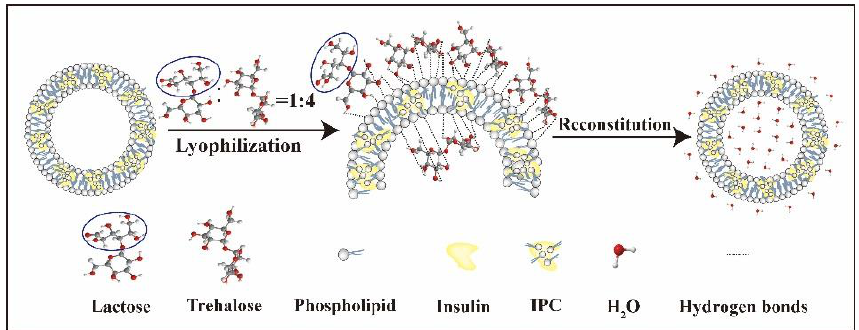
Figure 10. Protection mechanisms of the combination using of trehalose and lactose.